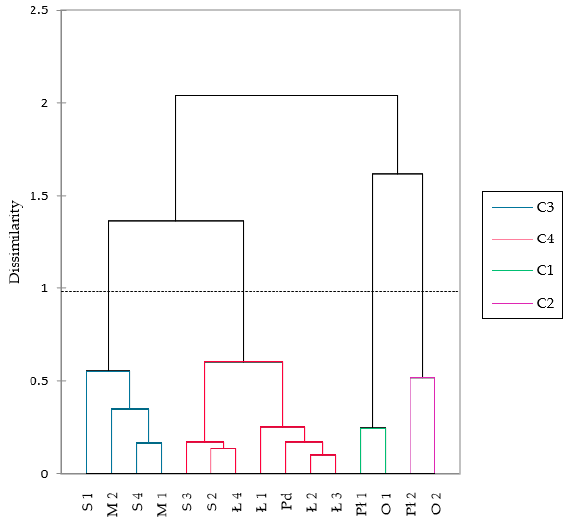
Figure 4. Cluster dendrogram of sites depending on plant composition. The floristic diversity index was also determined for all sites. The highest values were recorded at Lake Orchowe O2 (2.26) and in the mid-forest Stulno S3 bog (2.26), and the lowest at the Macoszyn M2 bog (1.38) (Table 5). Open stands with no participation of woody vegetation achieved higher values of the analysed index. Table 5. Index of Shannon–Wiener results. Site